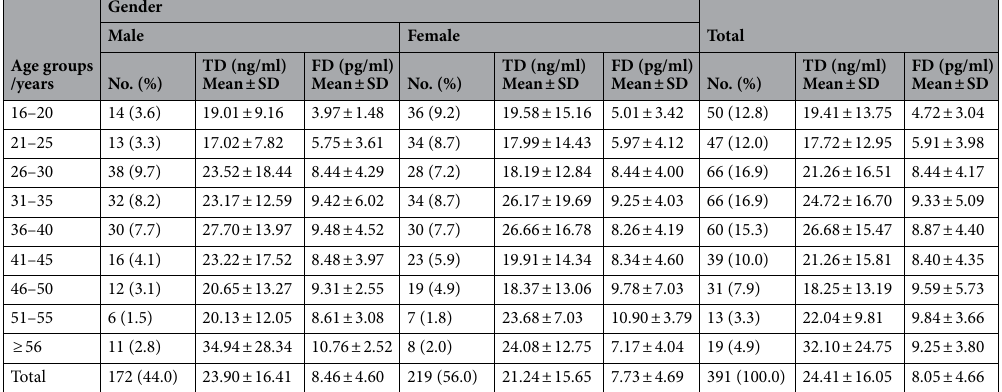
Table 1. Descriptive statistics with mean and standard deviation of Total 25-OHD and Free 25-OHD in respect to age groups and gender. (P-value = 0.297).